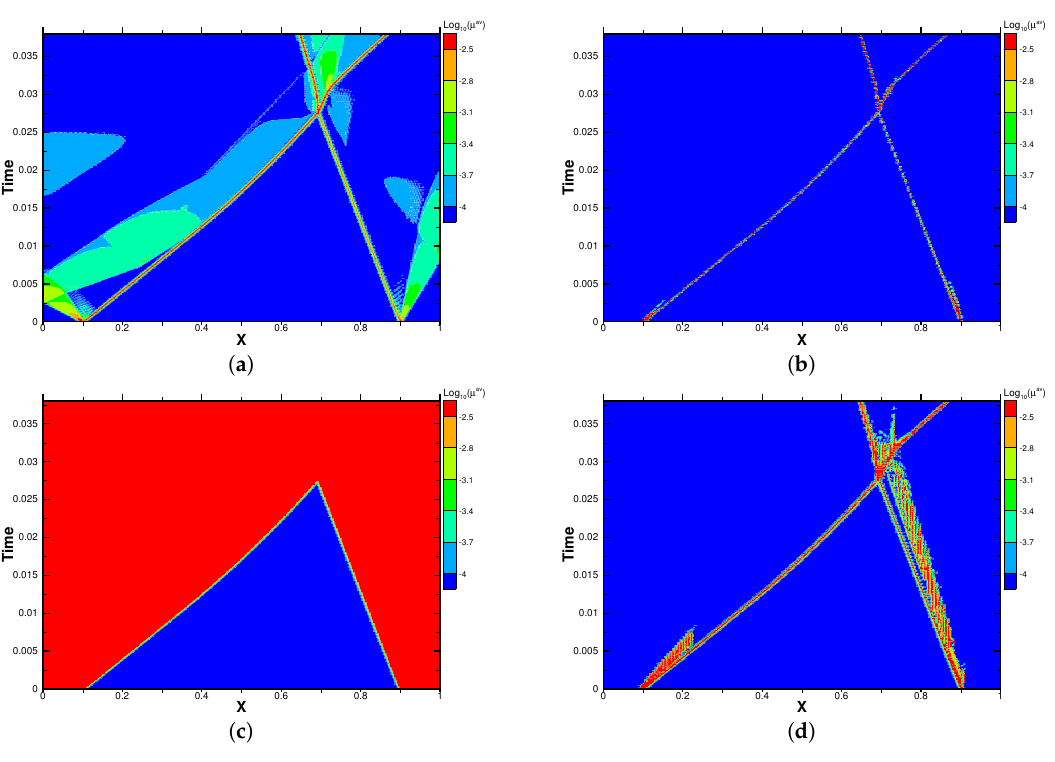
Figure 17. Temporal history of artificial viscosity the blast wave problem with 300 P 2 elements for t ∈ [ 0,0.038 ] . ( a ) DB; ( b ) MDH; ( c ) MDA; ( d )